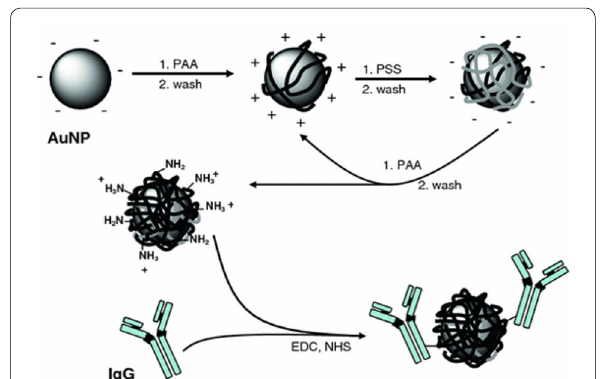
Fig. 4 Citrate stabilized gold nanoparticles coated with PSS and PAA in a Lbl method with the addition of IgG antibody through amide linkages. Reproduced from Ref. [52] with permission from Wiley